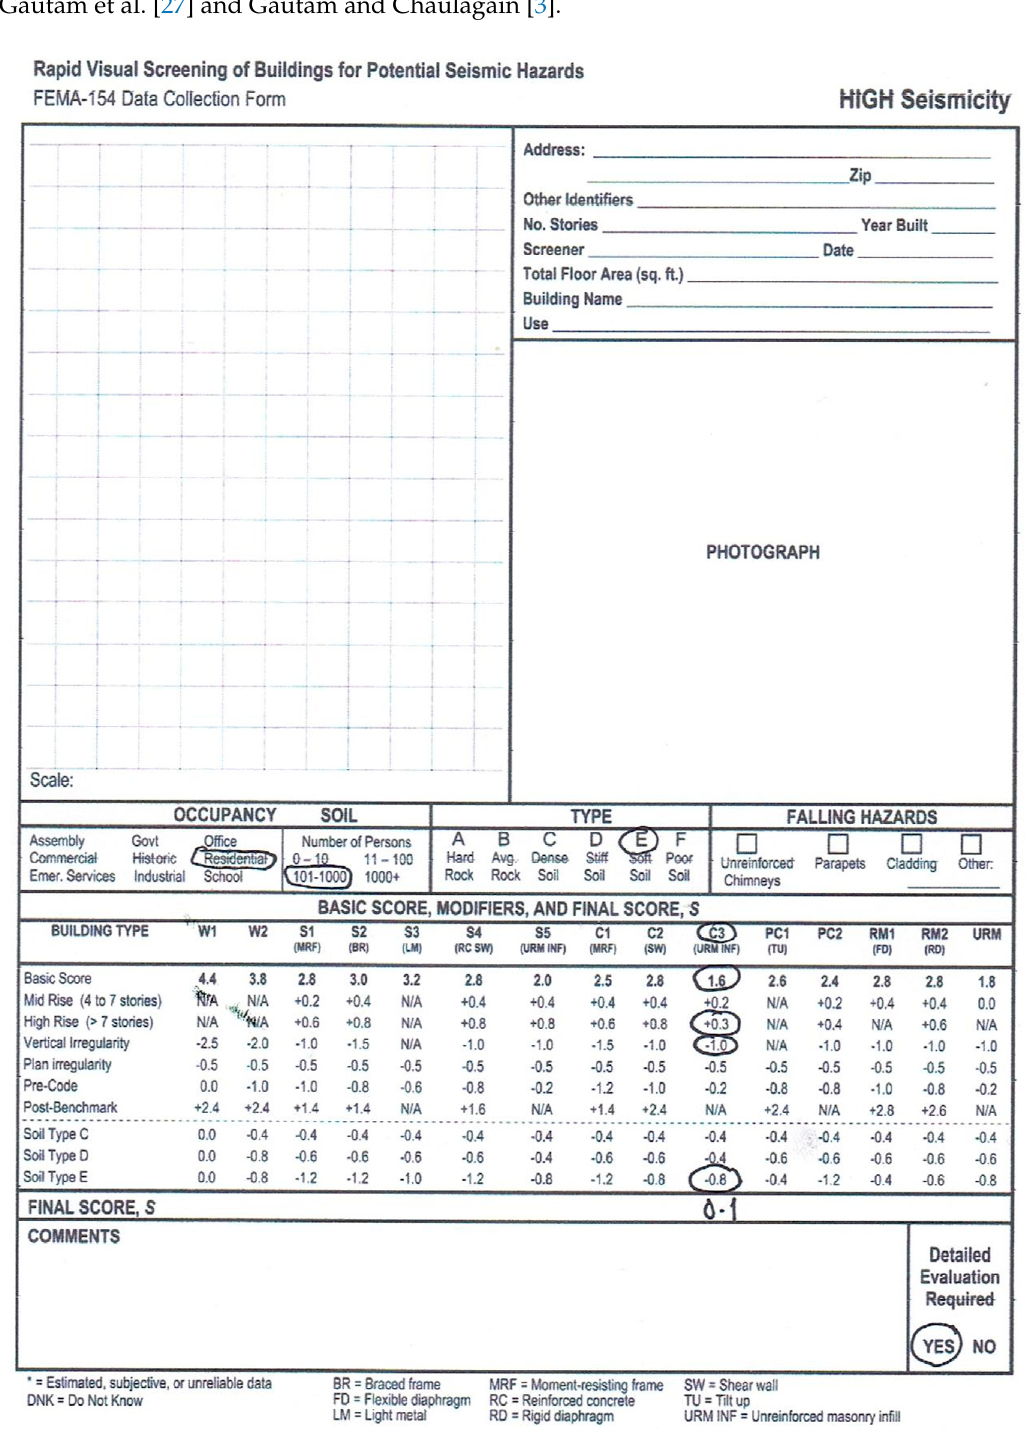
Figure 5. Summary of the rapid visual assessment of the building.